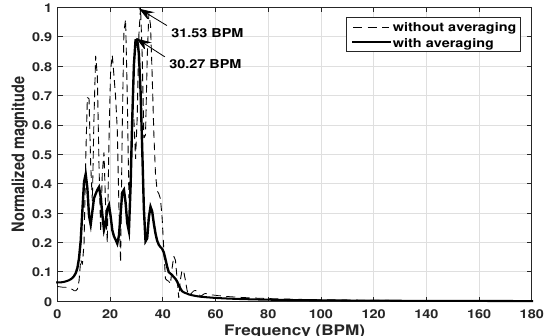
Figure 7. Respiratory frequency spectrum for the test no. 10.